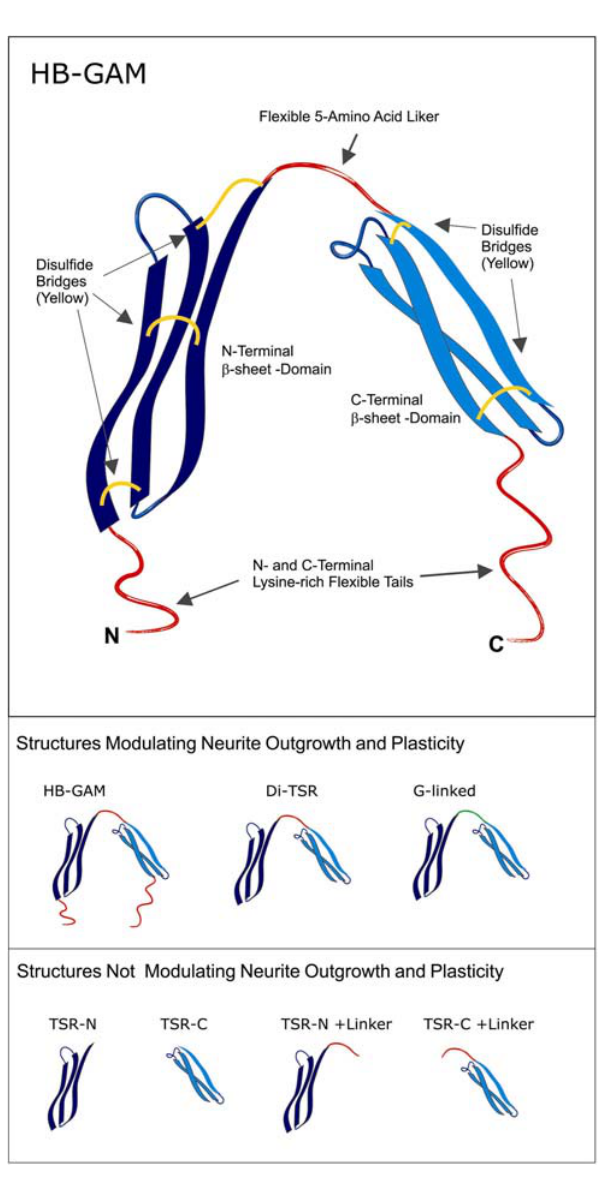
FIGURE 1 . Schematic presentation of structural features of HB-GAM. Structure/function dissection reveals a cooperative function of the two TSR domains in heparin/HS-binding modulating neurite outgrowth and synaptic plasticity. General characteristics of native HB-GAM molecule are shown (top panel). The biologically informative structure requires the presence of both TSR domains as implicated in the two lower